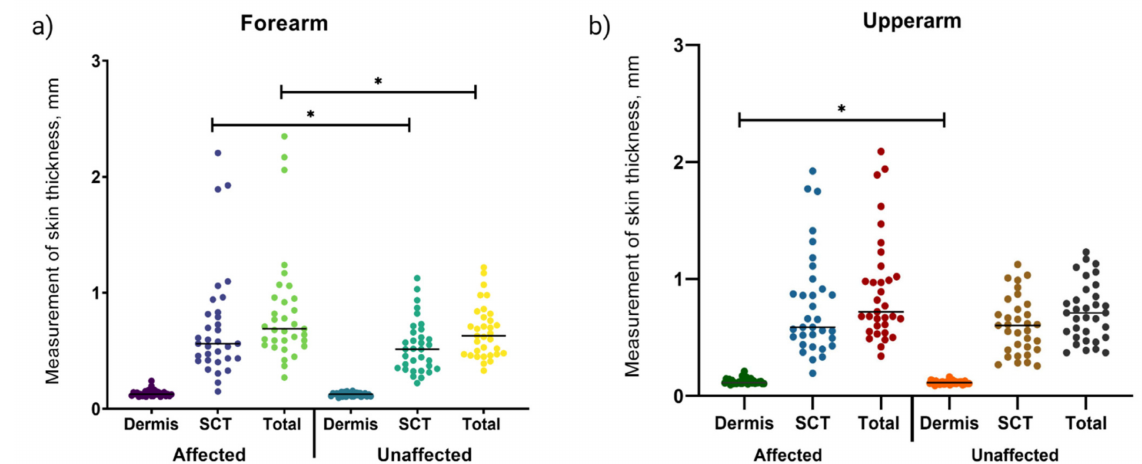
Figure 4. Comparison of skin thickness measurements of the dermis and subcutaneous layers as well as the total (sum of dermis and subcutaneous layer) between affected and unaffected arms evaluated in women with lymphedema ( n = 33). ( a ) Measurement of the forearm area of both affected and unaffected arms. A significant difference was found on the subcutaneous layer and total measurement between arms. ( b ) Measurement of the upper arm area, with significant difference on the dermis layer between affected and unaffected arms. * p value < 0.05 was calculated from Wilcoxon-signed rank analysis. Subcutaneous